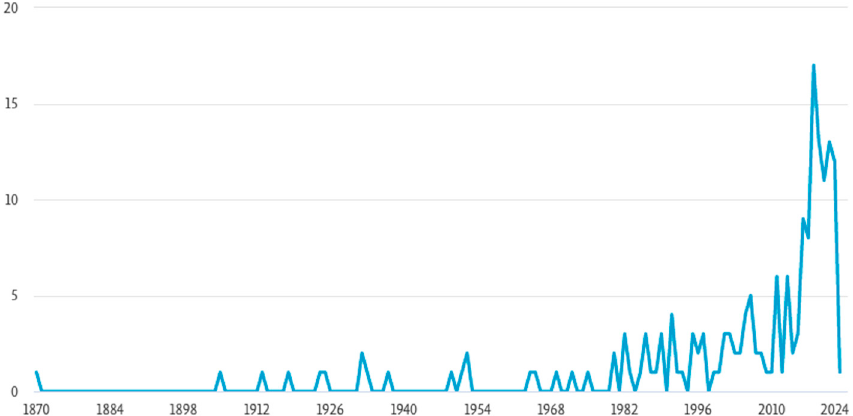
Figure 3. Number of publications per year (ordinate and abscissa axes, respectively) devoted to polybromides (19 December 2022; Scopus database, search TITLE-ABS-KEY (polybromide *)—177 examples).